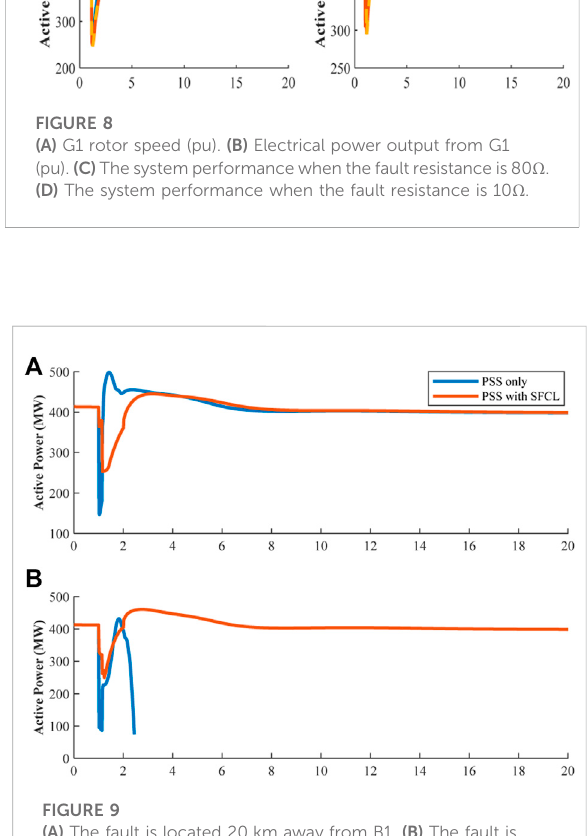
FIGURE 9 (A) The fault is located 20 km away from B1. (B) The fault is located 20 km away from